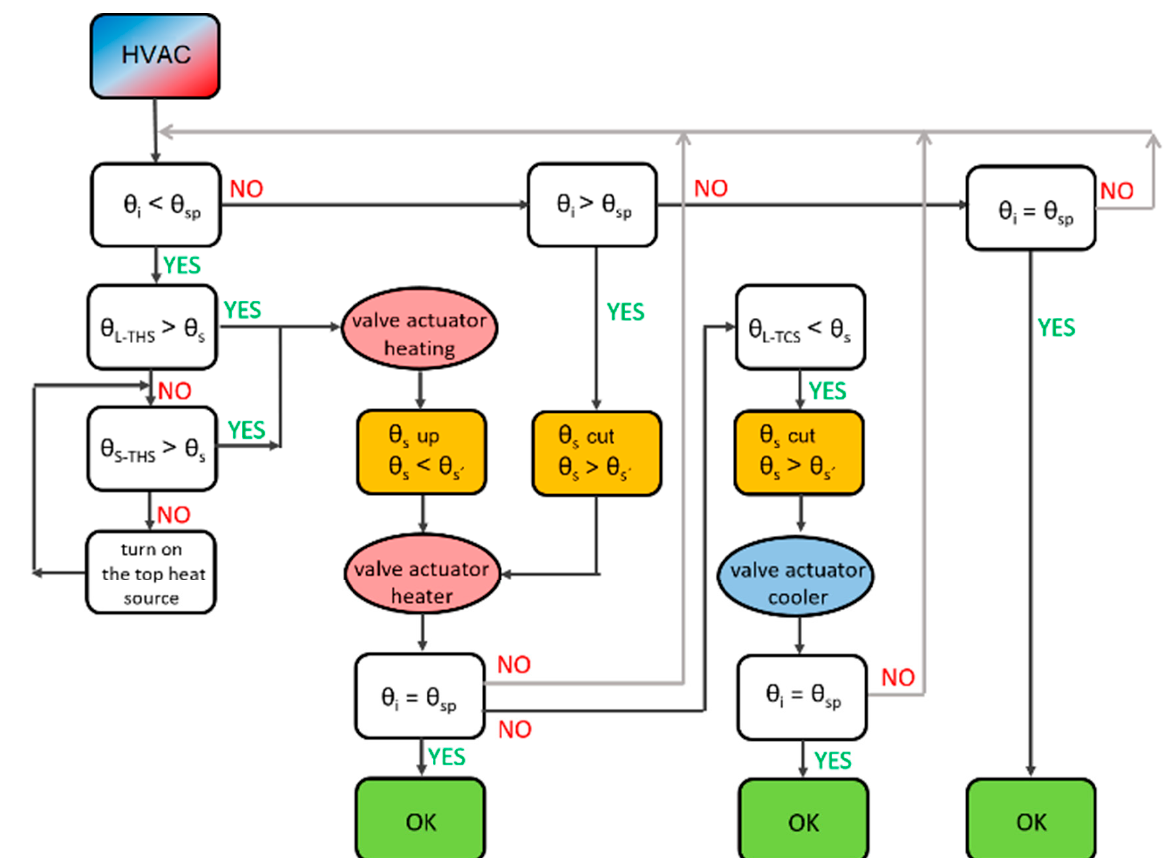
Figure 13. The indoor air temperature control principle during the operation of the recuperative air handling unit. θ i —indoor air temperature; θ sp —indoor air ttemperature setpoint; θ L-THS —output long-term heat store temperature; θ S-THS —output short-term heat store temperature; θ L-TC —output